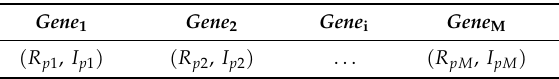
Table 1. Grey wolf chromosome